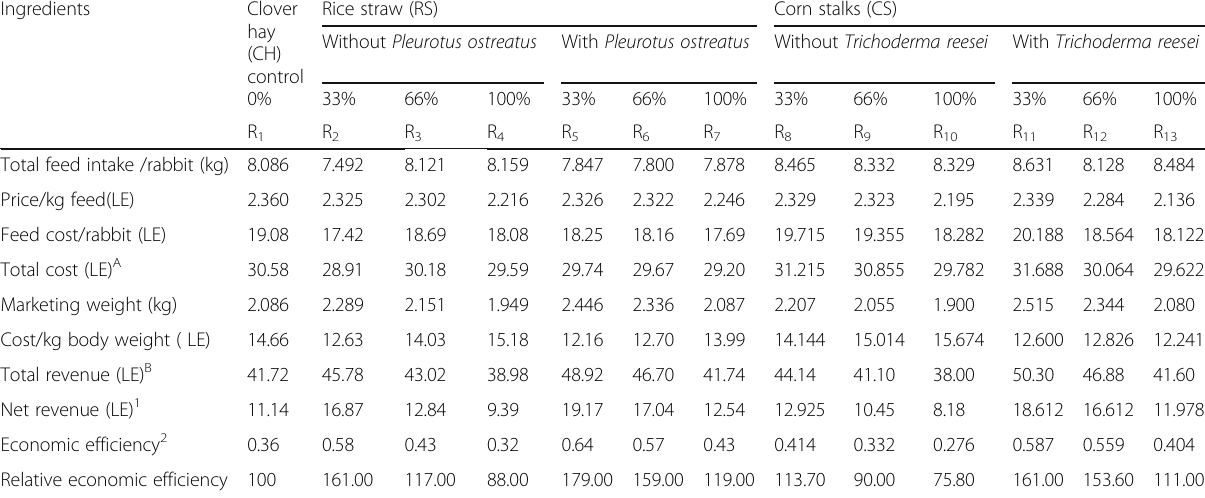
Table 7 Economic efficiency of the experimental groups